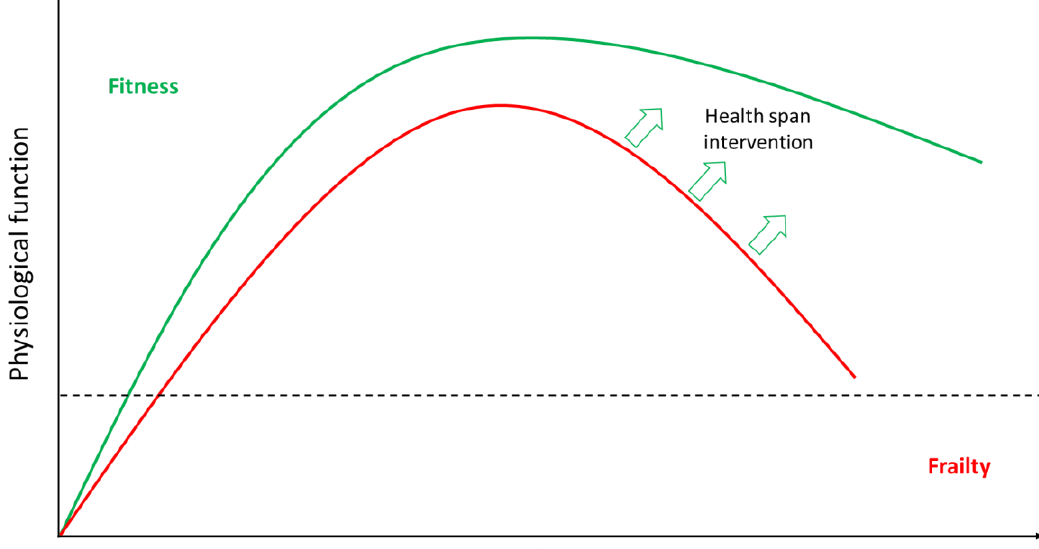
Figure 1. Schematic representation of different trajectories of ageing. The green line indicates a good trajectory for normative ageing. The red line indicates a poorer ageing trajectory, associated with a steeper decline in age-related physiological functional capacity. Loss of functional capacity results in fitness decline, frailty, and a greater risk of mortality. Improving the human health span would require interventions that are capable of pushing the poorer trajectory of ageing up and to the right, providing more years of good health and vitality.